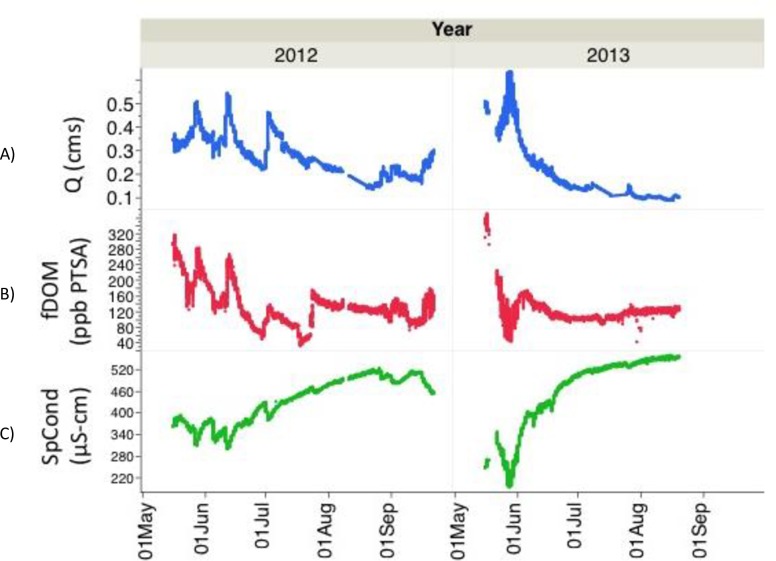
Real-time in-situ hydrologic data collected from sensors deployed in May Creek over 2012 and 2013 at 30 cm depth.Data are 5-minute averages of (A) discharge (in m3 s-1), (B) fDOM (in ppb PTSA standard), and (C) specific conductance (in μS-cm).